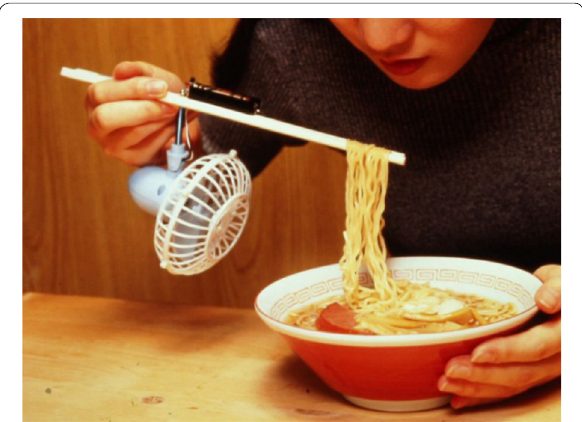
Fig. 2 The noodle cooler. Source: https ://www.tofug u.com/japan / chind ogu-japan ese-inven tions